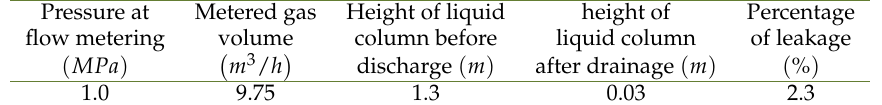
Table 7. Experiment on the effect of rotating plunger with 60 o inclination